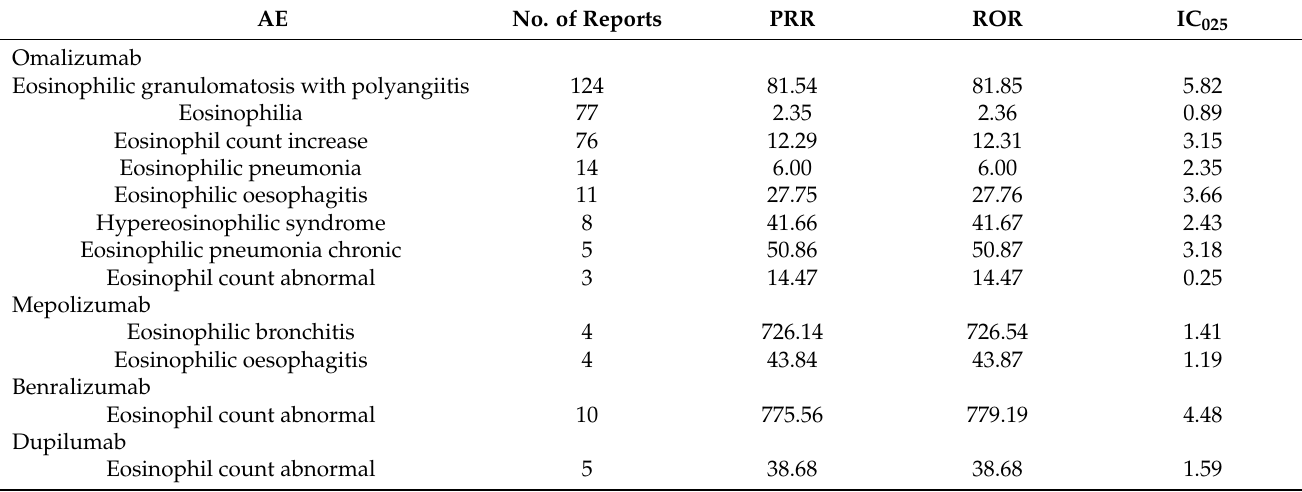
Table 6. Disproportionality analysis results of eosinophil-related AEs of biologics for